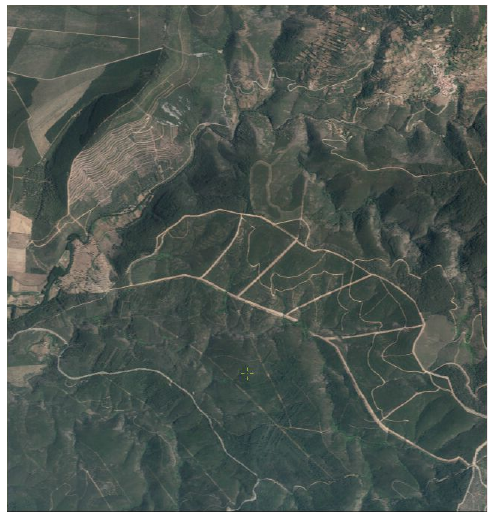
Figure 4: Corrected orthophoto mosaic (part 1)